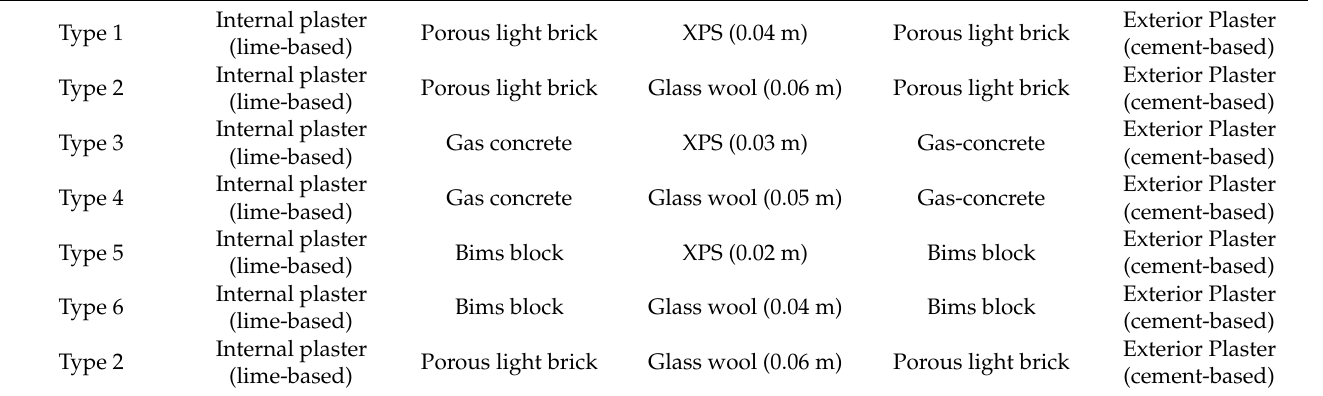
Table 5. The designed building types according to different building and insulation